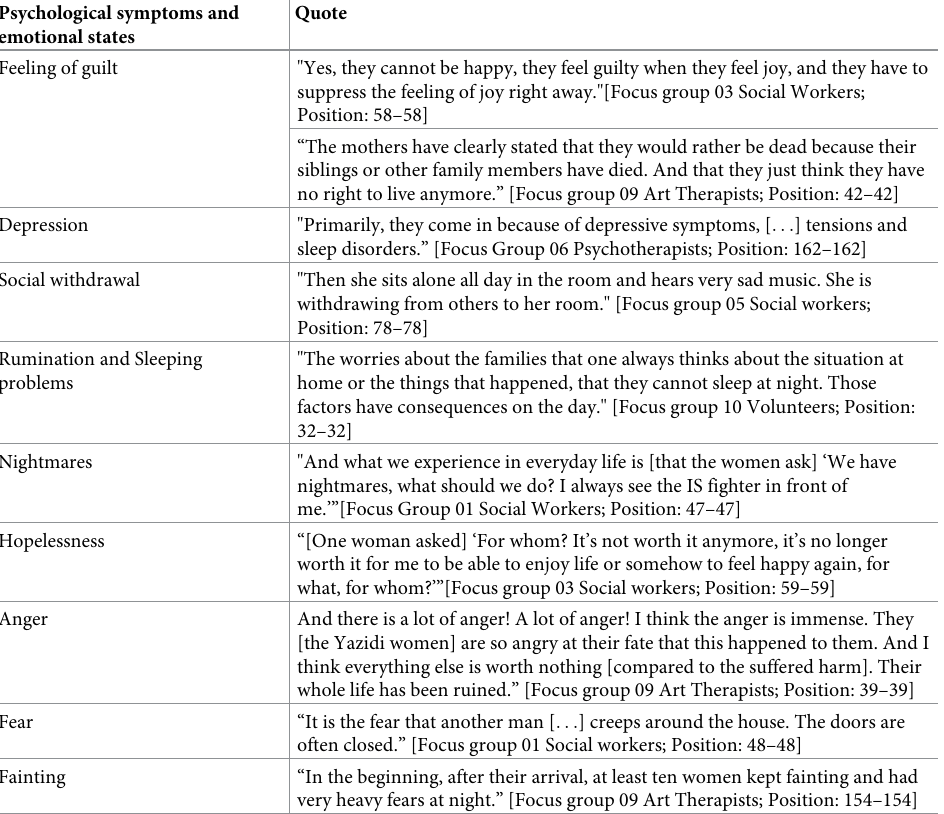
Table 3. Descriptions of psychological symptoms and emotional states of traumatized female refugees reported by care